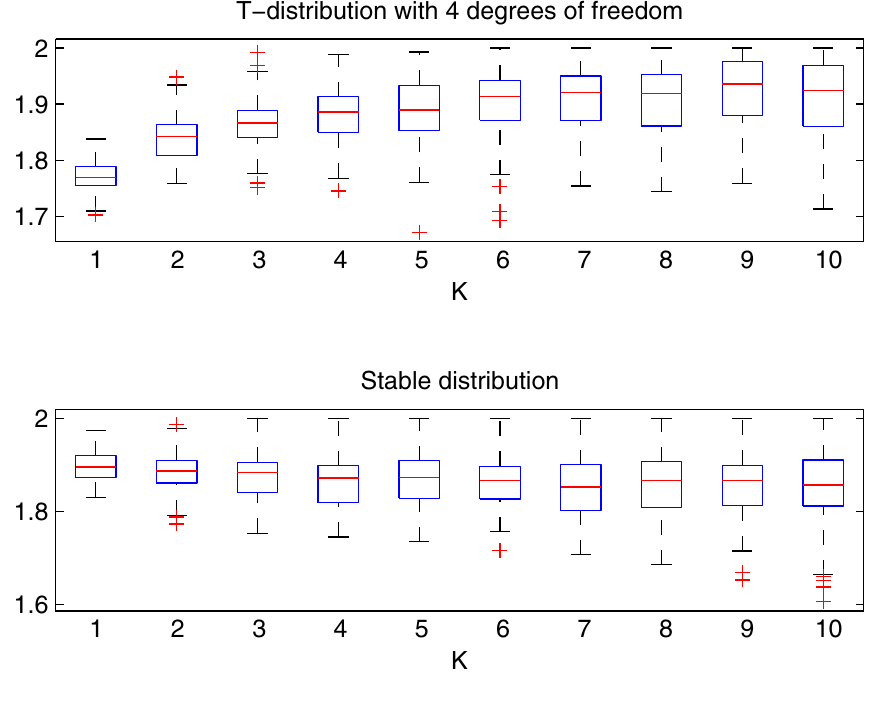
Fig 8. Estimated α values for the Student ’ s t sample from the top left panel of Fig 7 (top panel) and for the stable sample from the top right panel of Fig 7 (bottom panel). The box plots were constructed from 100 bootstrap samples of length